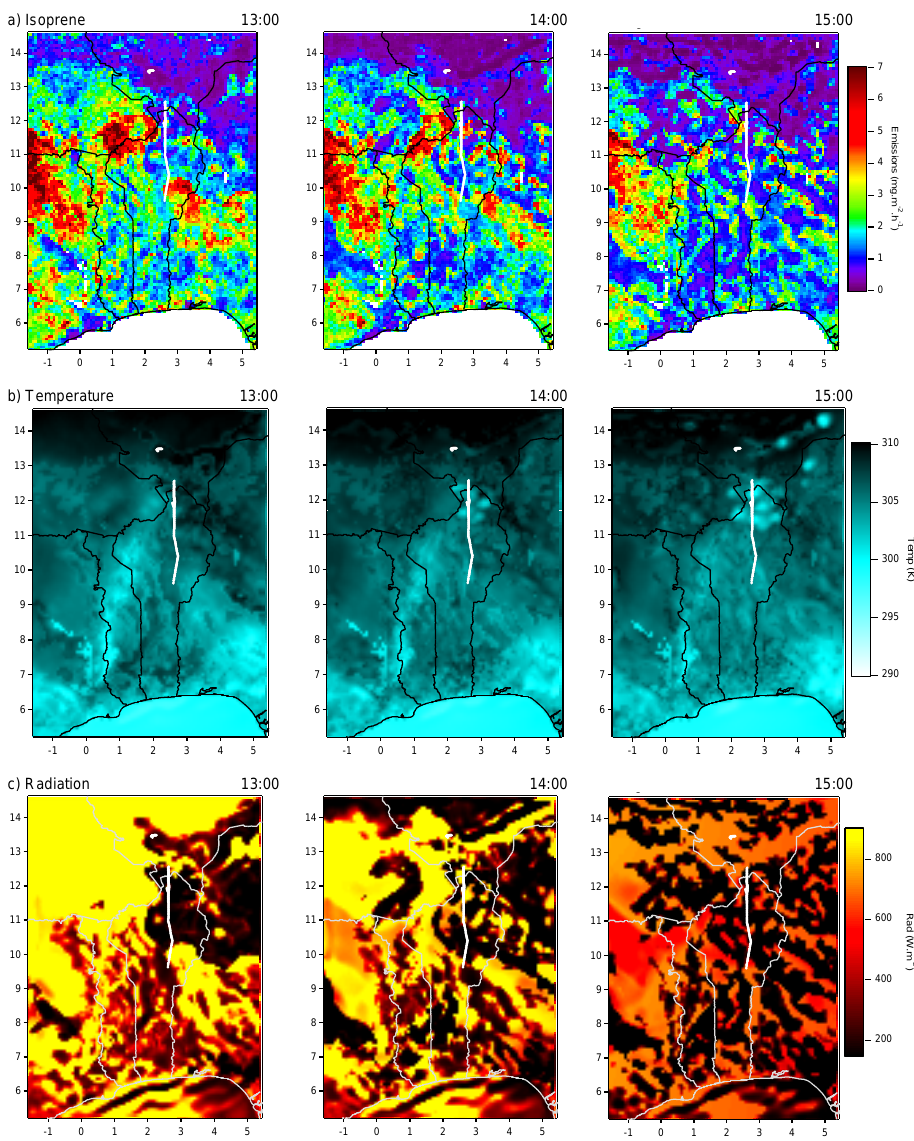
Figure 9 – Hourly surface fields of isoprene emissions (mg.m -2 .h -1 ) estimated by MEGAN at 9 km horizontal Fig. 9. Hourly surface fields of isoprene emissions (mgm − 2 h − 1 ) estimated by MEGAN at 9km horizontal resolution (a) , and temperature resolution (a), and temperature (K) (b) and radiation (W.m -2 ) (c) simulated by MM5 at 13:00, 14:00 and 15:00 (K) (b) and radiation (Wm − 2 ) (c) simulated by MM5 at 13:00, 14:00 and 15:00 for 17 August 2006. The flight track of the low level run of for August 17 th , 2006. The flight track of the low level run of flight B235 is shown by the white line. flight B235 is shown by the white